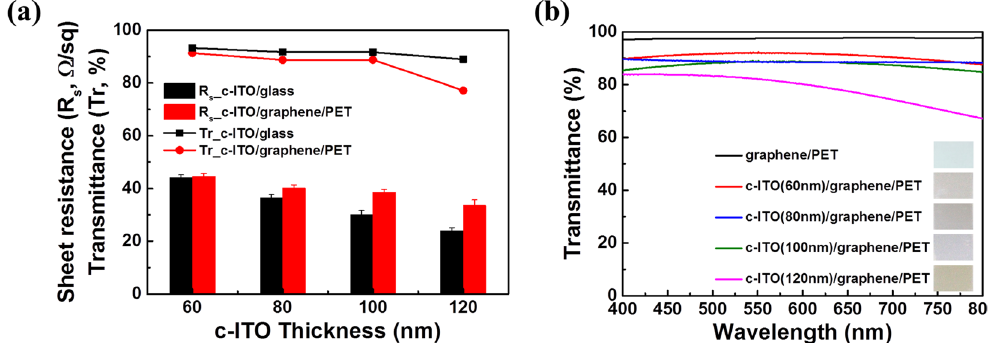
Figure 4. ( a ) Sheet resistance ( R s ) and transmittance (Tr; at a wavelength of 550 nm) of the c-ITO on different substrates (graphene/PET and glass). ( b ) Transmittance spectra of the c-ITO/graphene/PET films with various ITO thicknesses; the spectrum of graphene/PET is also shown for